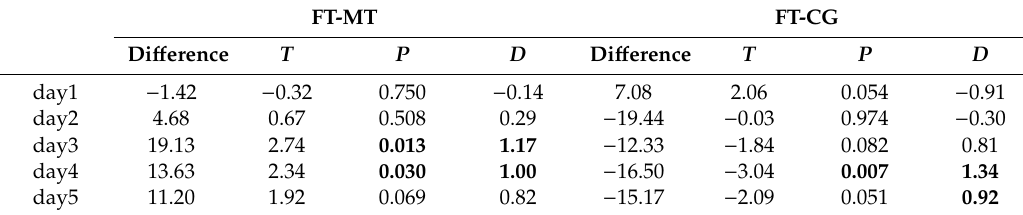
Table A4. Significance and e ff ect sizes for Deck B between the training groups.